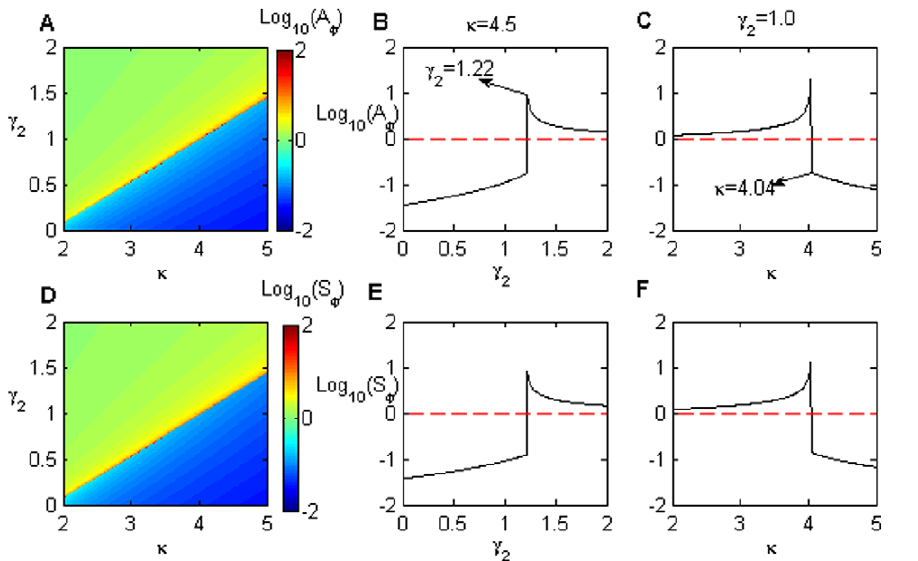
Figure 6. The effects of the positive feedback ( k ) and miRNA inhibition ( c 2 ) with an initial steady off-state. (A) The noise amplification and (D) the sensitivity of the protein module as a function of k and c 2 when the initial steady state is an off-state in the bistable region. The parameter values are a ~ 0 : 15 , c 1 ~ 1 : 0 , e ~ 0 : 05 , t 0 ~ 0 : 5 . A w and S w for k ~ 4 : 5 (B, E) and c 2 ~ 1 : 0 (C, F), respectively. Note that A w and S w reach their maximum values at c 2 ~ 1 : 22 (B, E) and k ~ 4 : 04 (C, F), respectively.